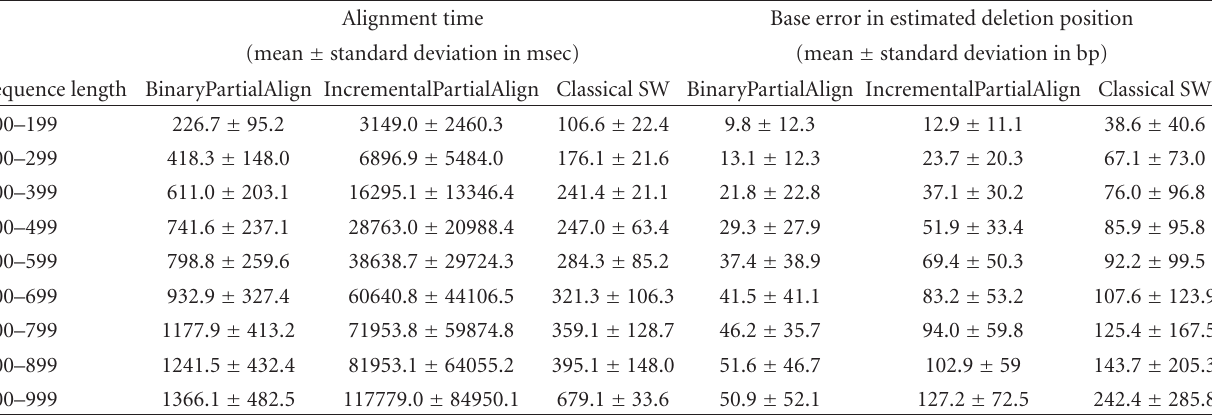
Table 1: Alignment times of BinaryPartialAlign, IncrementalPartialAlign, and classical